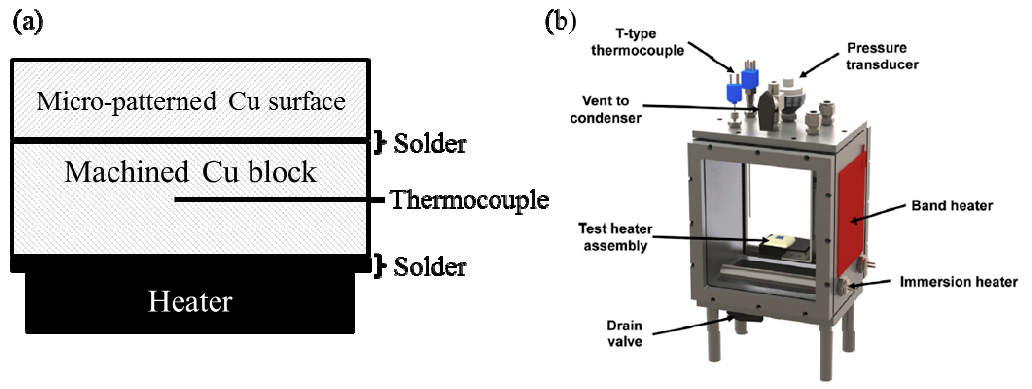
Figure 2. ( a ) Schematics of test heater assembly (schematic not to scale); (b) test chamber